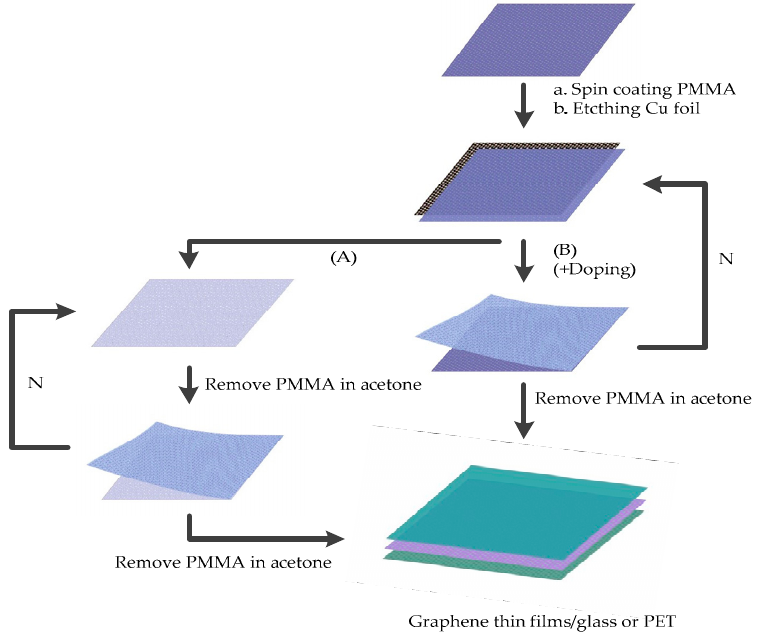
Figure 6. Preparation process of graphene counter electrodes applied in perovskite solar cells.